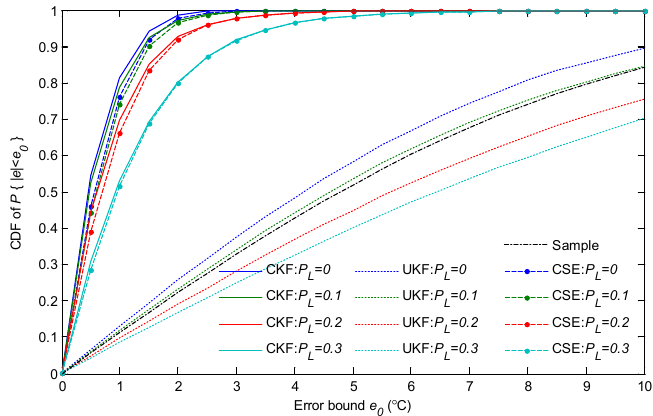
Figure 10. The CDF of the absolute error of surface temperature estimation with different packet loss probabilities; one retransmission was scheduled for each packet